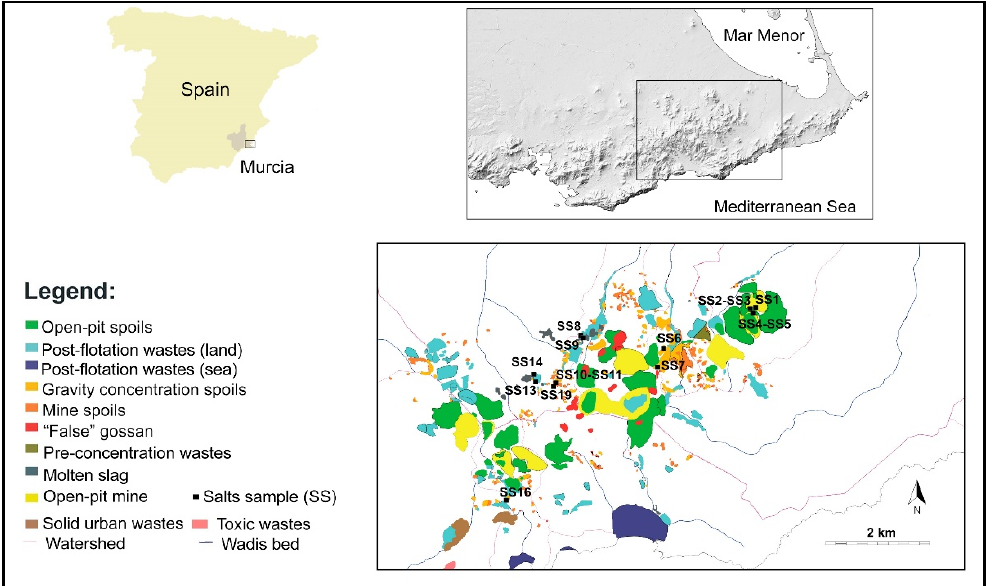
Figure 1 . Distribution of the 15 sampling sites (SS) where specimens of salt efflorescences were collected. Modified from [31].